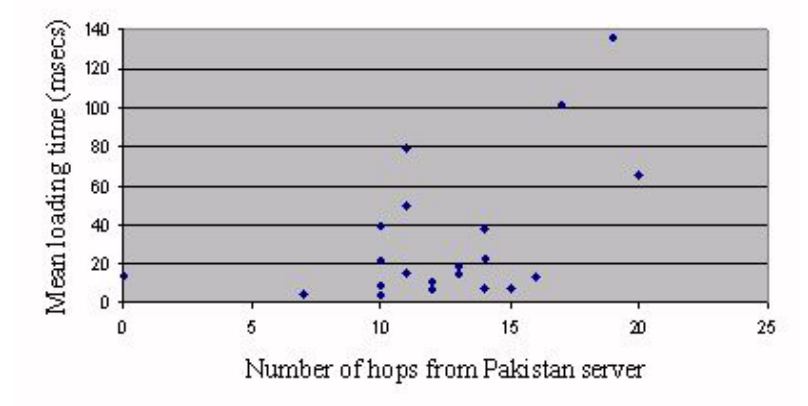
Figure 4. Browser loading speed versus server